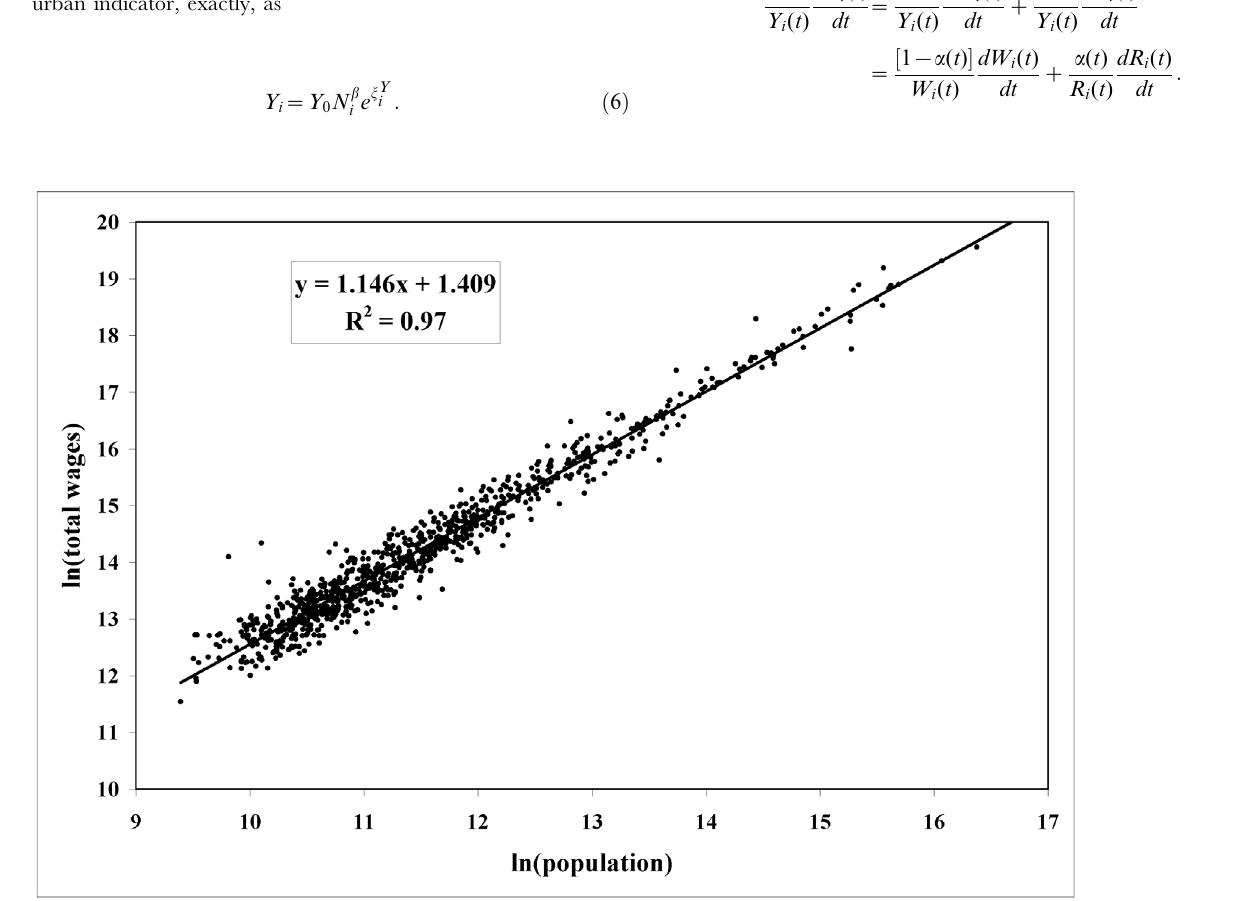
Figure 1. Scaling of total wages using data for all 943 urban areas of the United States (smoothed over the 2009–2011 period) showing superlinear scaling.